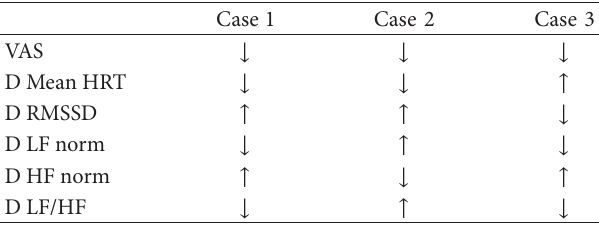
Table 1: Fluctuation of differential frequency-/time-domain param- eters during